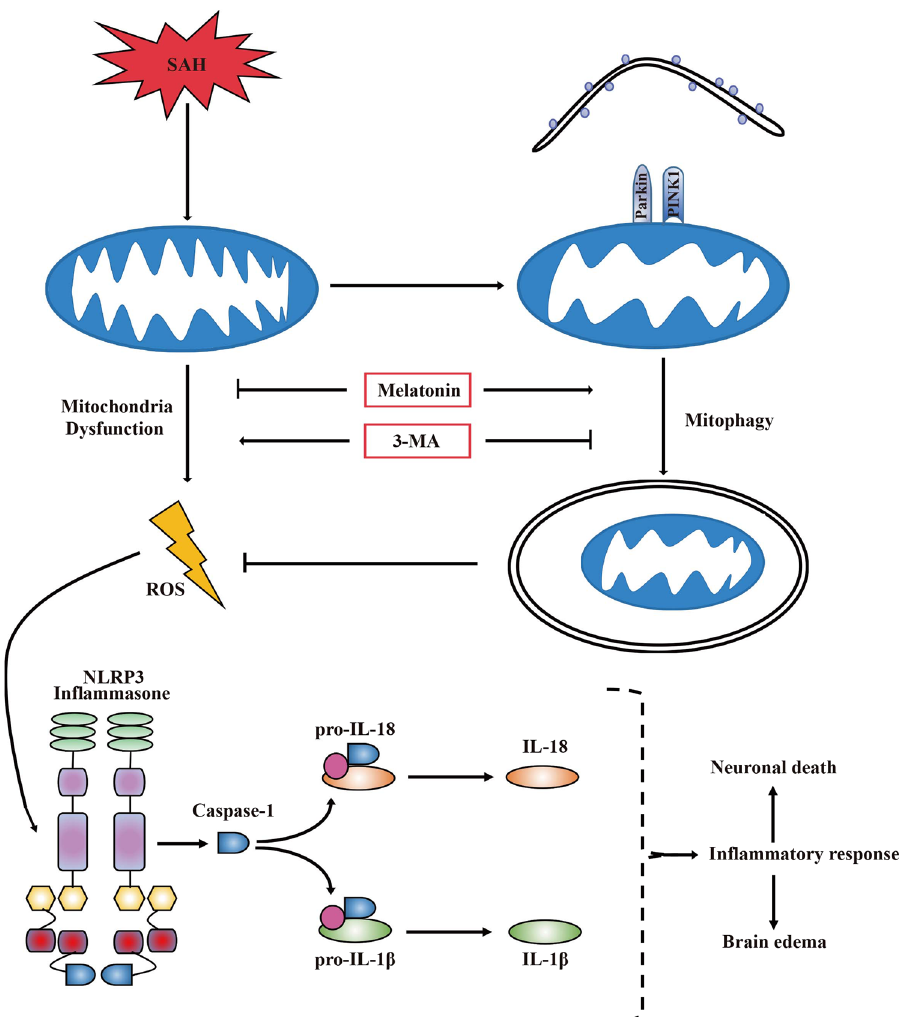
Figure 7. A potential process illustrating the effect of melatonin on mitophagy and the NLRP3 inflammasome following SAH. Briefly, SAH-induced damaged mitochondria released ROS and then activated the NLRP3 inflammmasome and secondary inflammatory responses. Treatment with melatonin upregulated mitophagy and reduced ROS generation, which resulted in positive feedback to inhibit the NLRP3-mediated inflammatory response. Mitophagy inhibitor 3-MA pretreatment reversed the beneficial effect of melatonin on the inhibition of the NLRP3-induced inflammatory